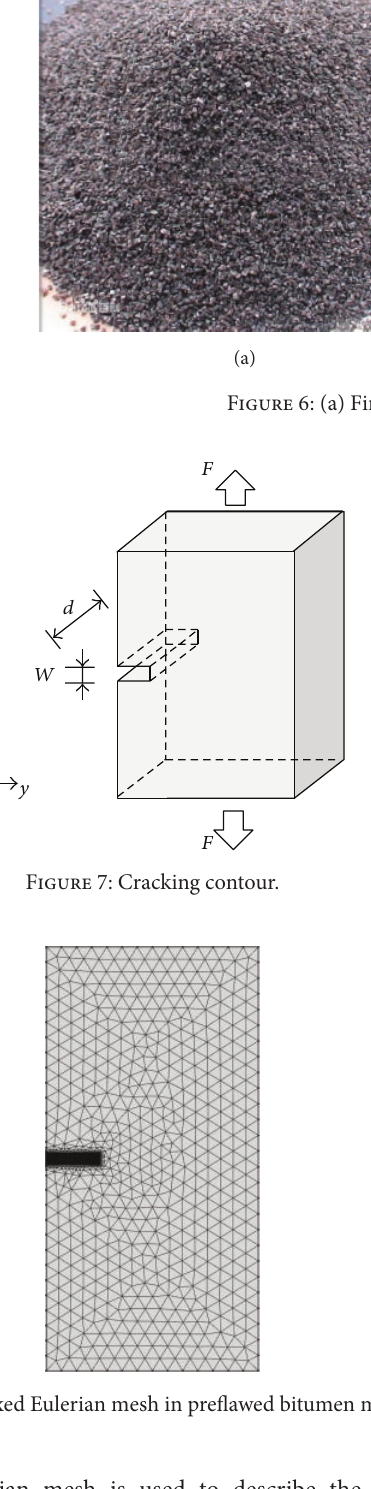
interfaces between the intact solid and crack void, as